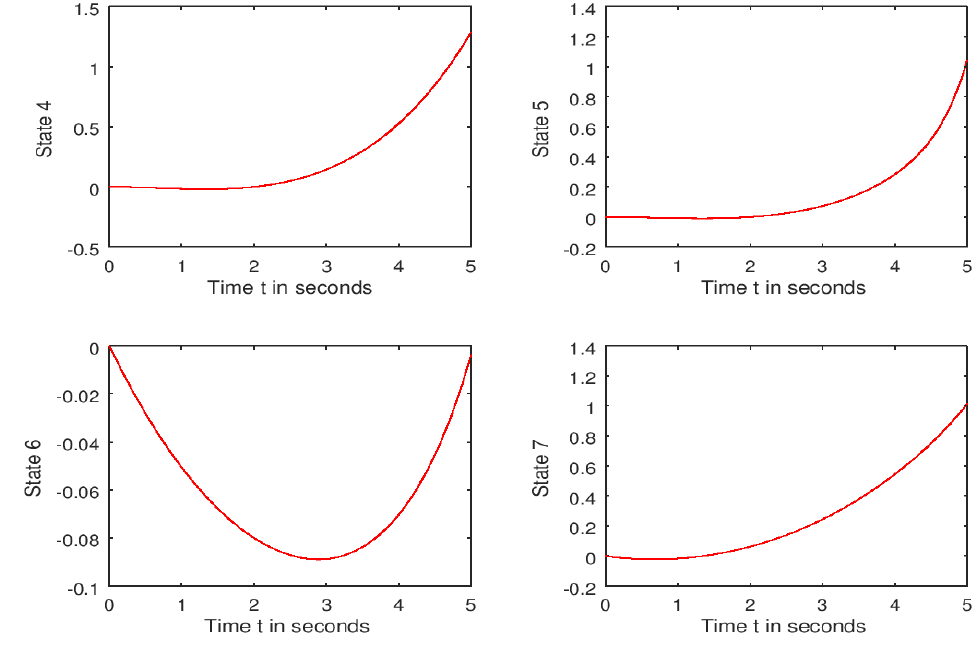
13 of 22 Figure 4. Feasible first three state functions.